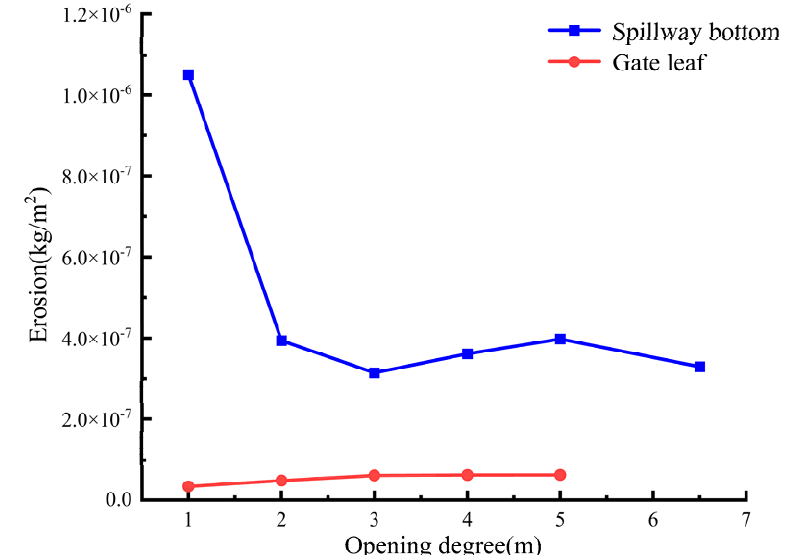
Figure 15. Relationship between erosion and gate